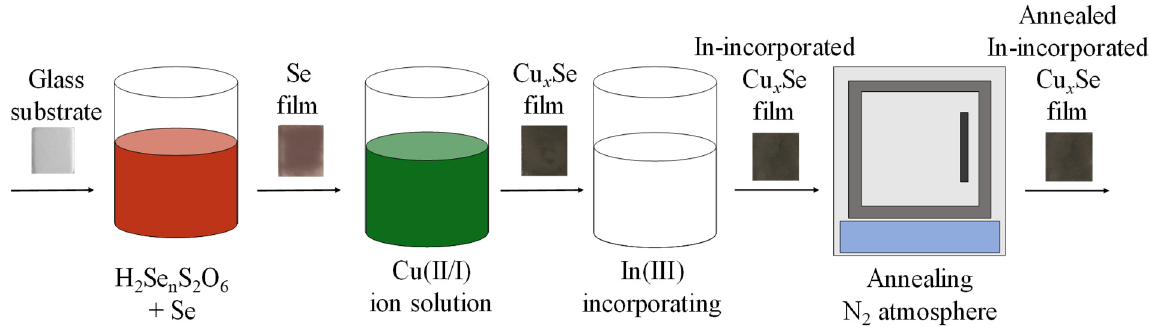
Figure 1. Schematic representation of In-incorporated Cu x Se film on glass